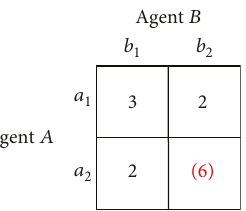
Figure 1: The payo ff matrix of a fully cooperative repeated